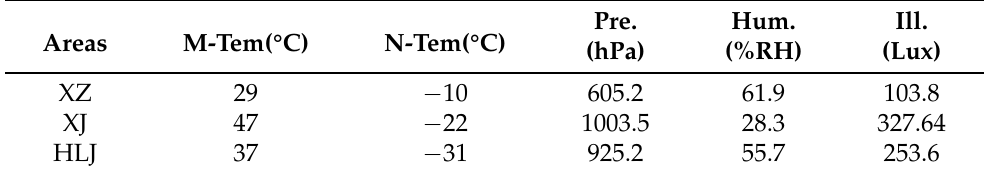
Table 1. Environmental features of true typical